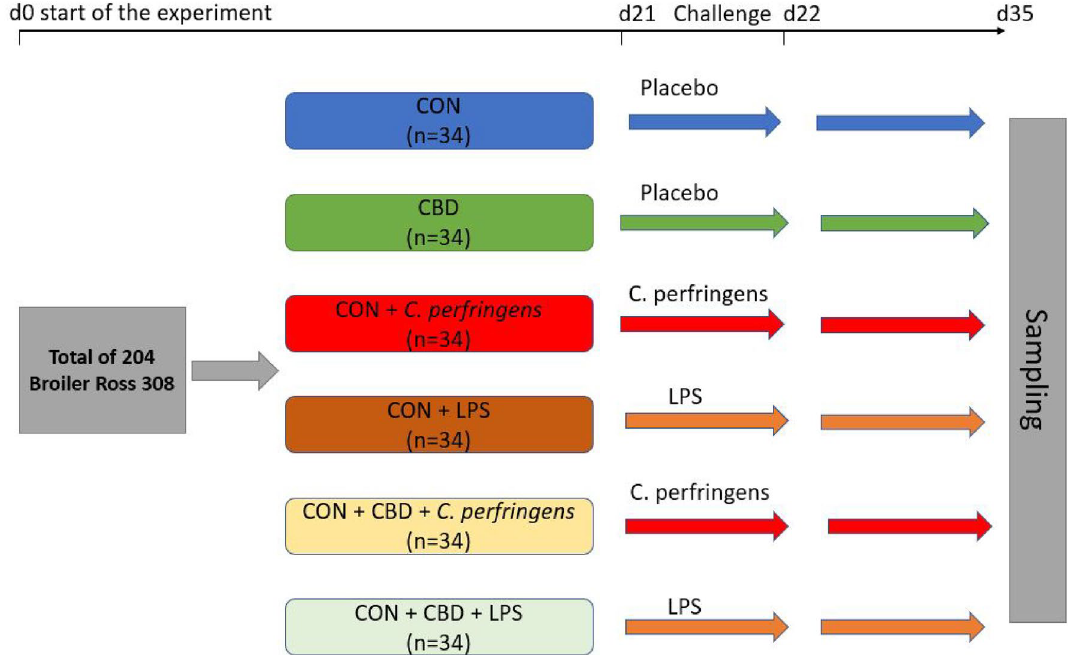
Figure 5. Scheme of the experimental treatments and applied challenge. CON: received the basal diet over the entire period of the experiment (until 35 days of age) and no challenge; CBD: received the CON diet supplemented (on top) with 30 g/kg Cannabis sativa extract; C. perfringens and LPS: received the CON diet and subjected to C. perfringens and E. coli LPS challenge at days 21 and 22 of age, respectively; CBD + C. perfringens and CBD + LPS: received the CBD diet and subjected to C. perfringens and E. coli LPS challenge, respectively.